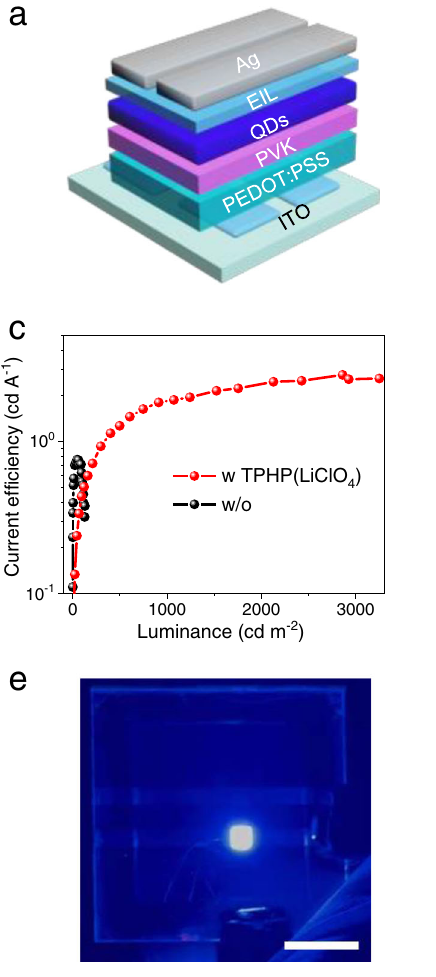
bottom one. Except for good conductance, high transparency and low WF , as the fi nal processed layer, the processing of the top electrode